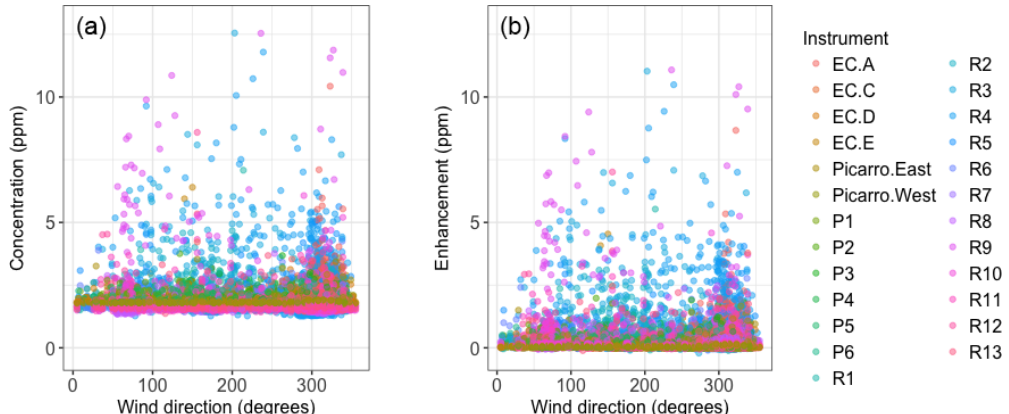
Figure 4. (a) Raw averaged concentrations, plotted by instrument and against wind direction. (b) Enhancements obtained by subtracting off the background and instrument-specific